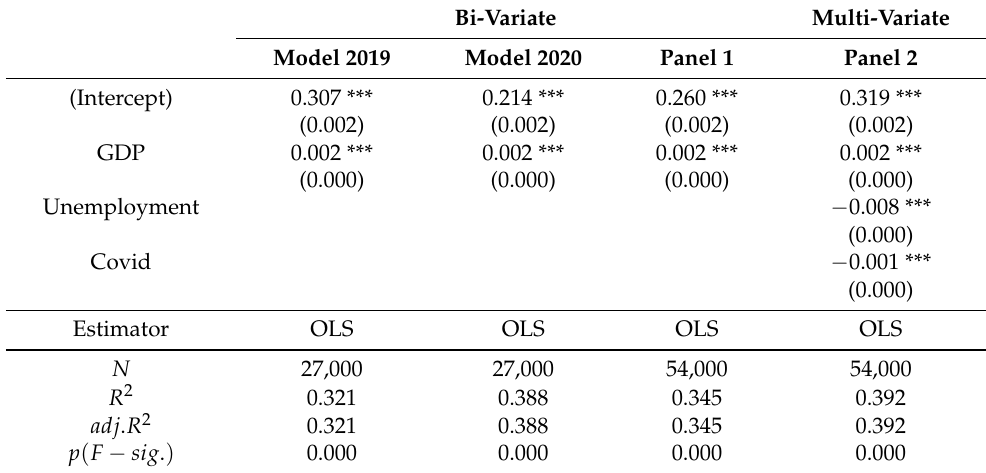
Figure 3. Simulation Regression: The blue color represents the simulation of the scatter and regression line with 99% confidence interval of the 2019 data. The red color represents the simulation of the scatter and regression line with 99% confidence interval of the 2020 data. Source: author. Table 4. Simulation Regression